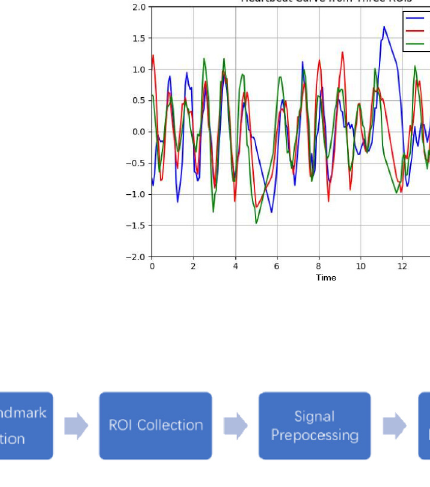
Figure 2. Structure of the proposed